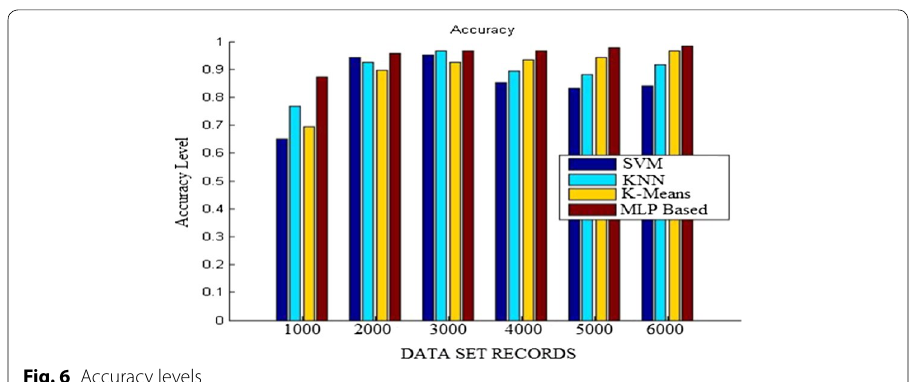
Fig. 6 Accuracy levels